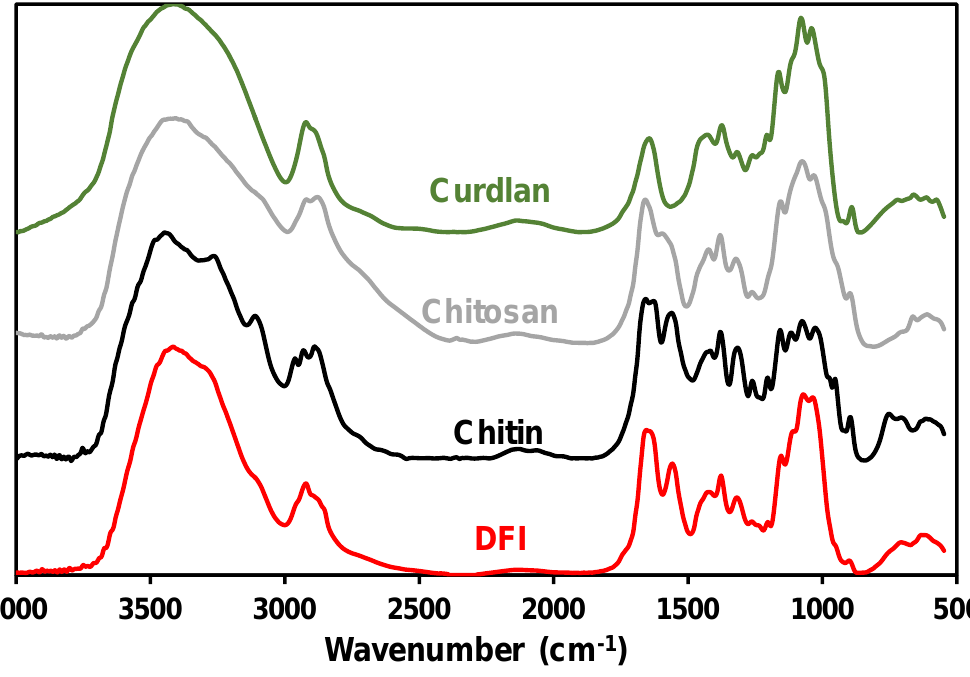
Figure 2. FTIR spectra of the DFI obtained in treatment nº 4 and of the reference polysaccharides chitin, chitosan and curdlan.